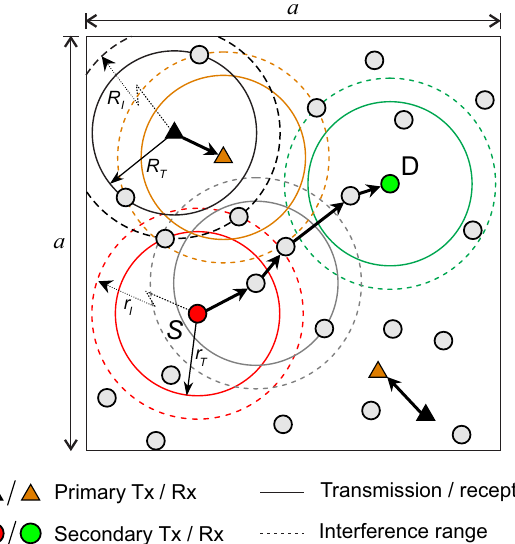
Figure 1. The system model of the considered cognitive radio ad-hoc networks (CRAHNs) with multiple one-hop-communication primary networks and the difference in transmission range and interference